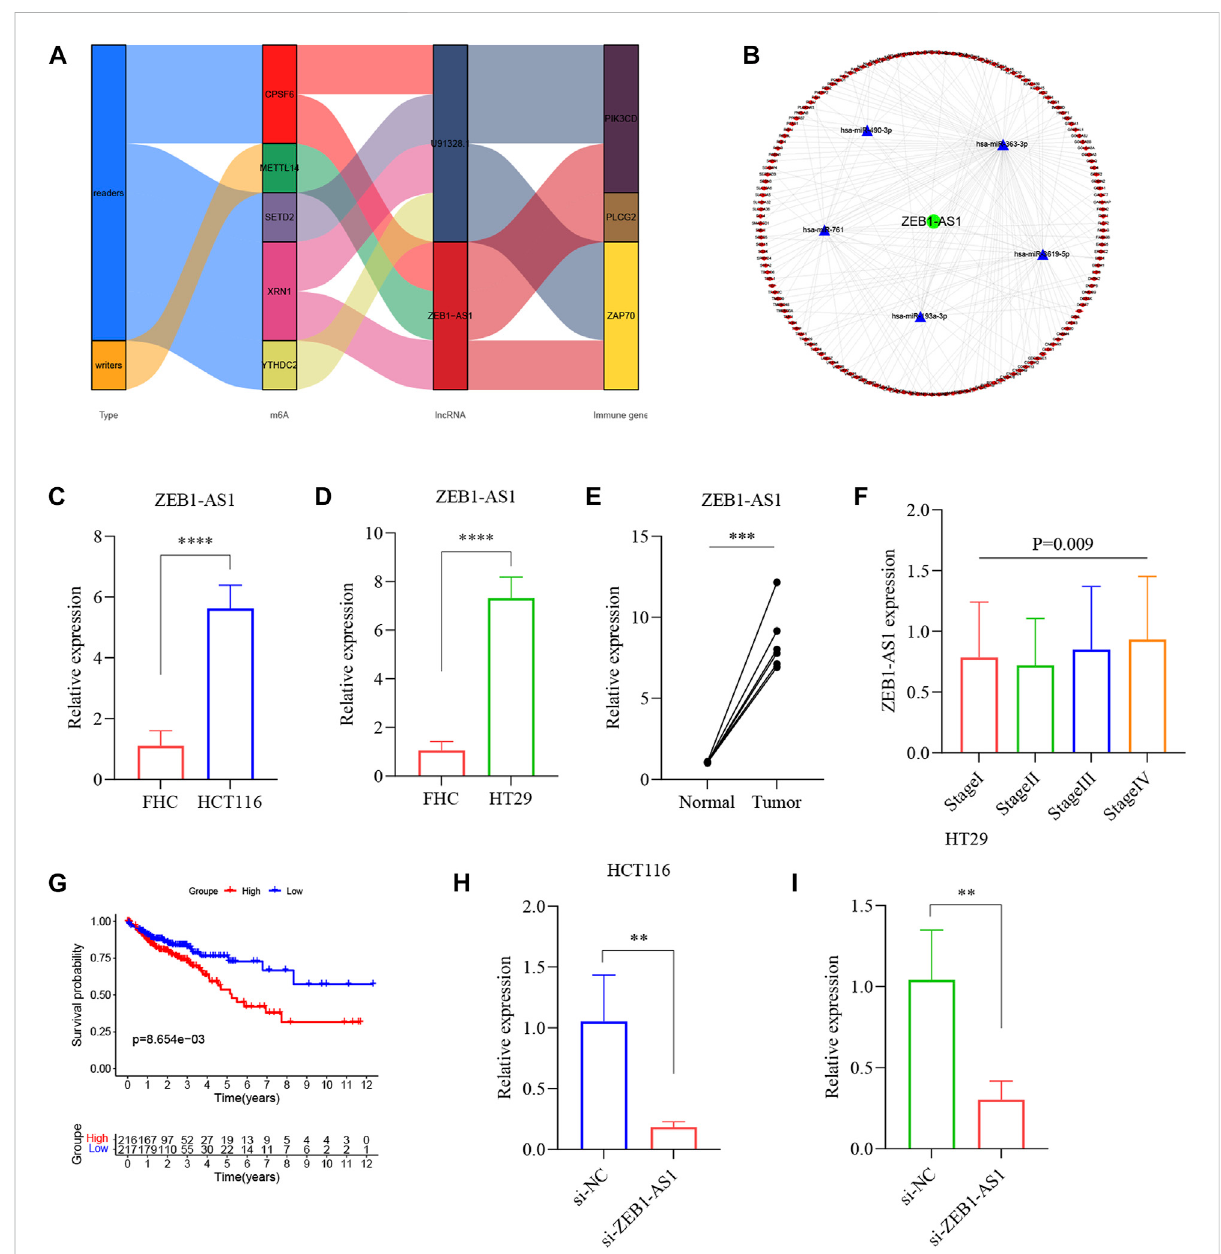
FIGURE 12 Validation of ZEB1-AS1 in CRC tissues and cell lines. (A) The sankey diagram depicted the relationship between 5 m6A regulators, 2 lncRNA signatures and 3 immune genes. (B) The ceRNA network basedon 2 lncRNA signatures. (C,D) Bar plot for therelativeexpressionofZEB1-AS1 inCRC cell lines and normal cell line. (E) Bar plot for the relative expression of ZEB1-AS1 between CRC tissues and normal tissues. (F) The correlation of ZEB1-AS1 expression with clinicopathological staging characteristics. (G) Survival analysis for CRC patients with different ZEB1-AS1 expression. Patients were labeled with high expression or low expression depending on the comparison with the median expression level. (H,I) Transfection ef fi ciency of ZEB1-AS1 siRNA was determined by RT-qPCR. ** p < 0.01; *** p < 0.001; **** p <